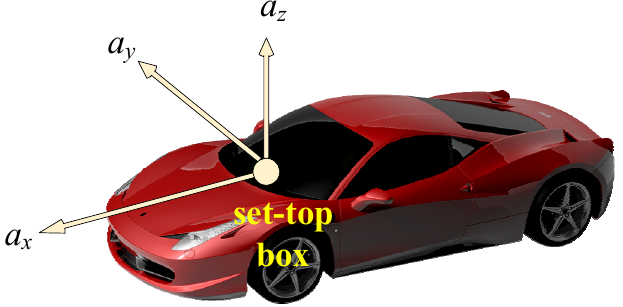
(radii) of the two points (absolute value), and d is the straight-line distance between P and Q on the ground. Figure 3. Three-axis orientation sensing of the attitude indicator of the STB.